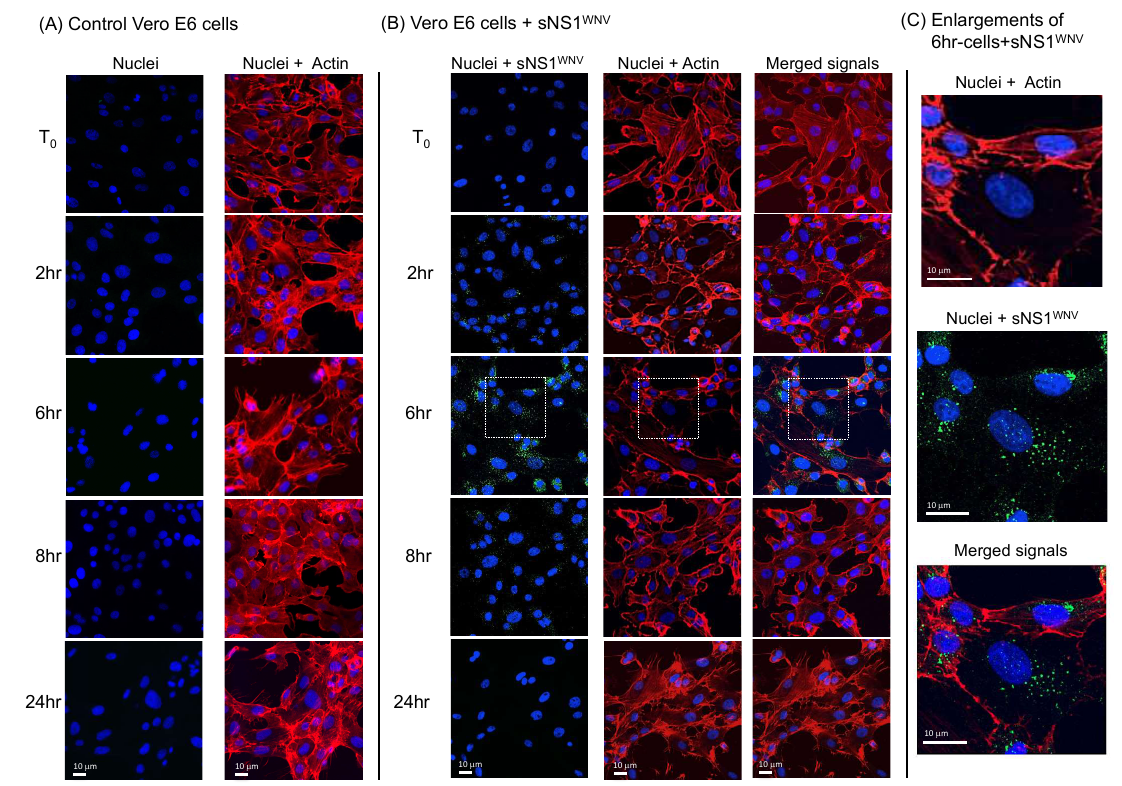
Figure 4. Time-course analysis of the cellular uptake of sNS1 WNV by Vero E6 cells. Extracellular, soluble H 6 -tagged sNS1 WNV protein, released by pNS1 WNV-IS98 -transfected HEK-293T cells and purified by a ffi nity chromatography, was added to the cell culture medium of Vero E6 cells at 10 µ g / mL. Control, mock-treated cells consisted of cells incubated with aliquots from the culture medium of HEK-293T cells transfected with empty plasmid pcDNA3.1, and were subjected to the same chromatographic process as the culture supernatant of pNS1 WNV-IS98 -transfected cells. Cells were fixed at di ff erent periods of incubation at 37 ◦ C in the presence of sNS1 WNV (0 to 24 h, as indicated on the left side of panels ( A , B ), and analyzed by confocal fluorescence microscopy. ( A ) Control Vero E6 cells. ( B ) Vero E6 cells incubated with sNS1 WNV . ( C ) Enlargements of microscopic images of sNS1 WNV -treated cells (6 h incubation time, delineated by a white square). Actin microfilaments (red) were visualized using rhodamine–phalloidin, nuclei (blue) were visualized using dihydrochloride (DAPI) reagent, and sNS1 WNV protein (green) was immunolabeled using anti-NS1 WNV rabbit antibody. Note that images in panels ( A – C ) show the same areas at a given time